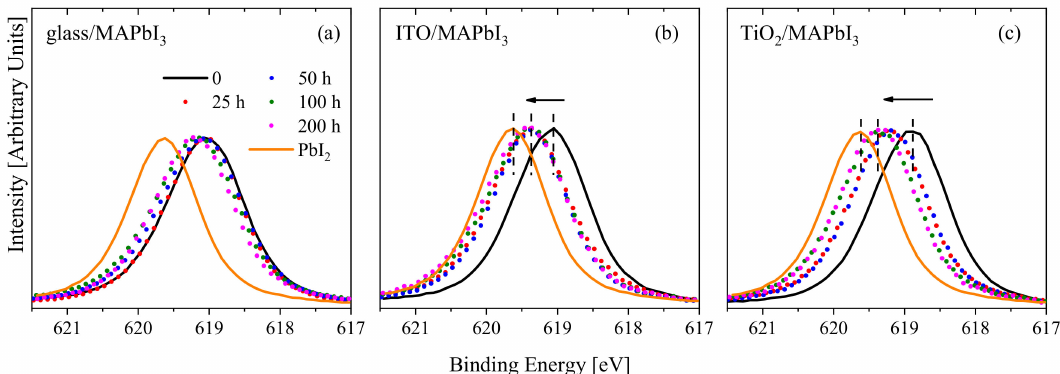
Figure 7. XPS I 3d 5/2 spectra of light-soaked MAPbI 3 hybrid perovskites prepared on different substrates: ( a ) glass, ( b ) ITO, and ( c ) TiO 2